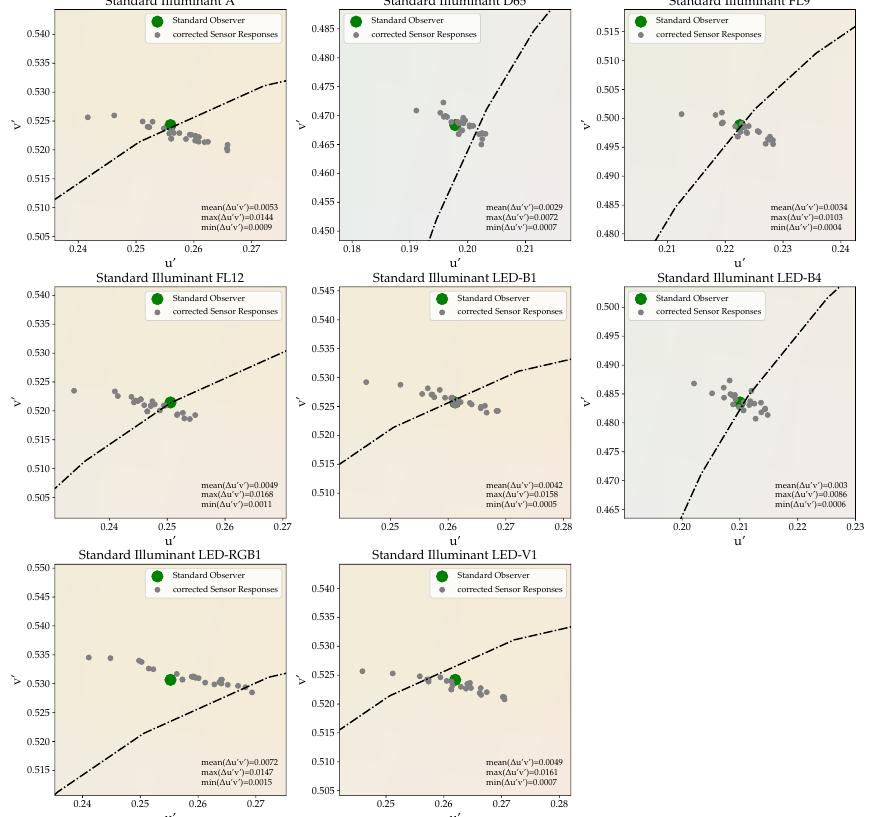
Figure 6. Chromaticity coordinates of the selection of test spectra “T” obtained for the 24 same-type true color sensors considered in this work. A single transformation matrix is used for the color correction of all